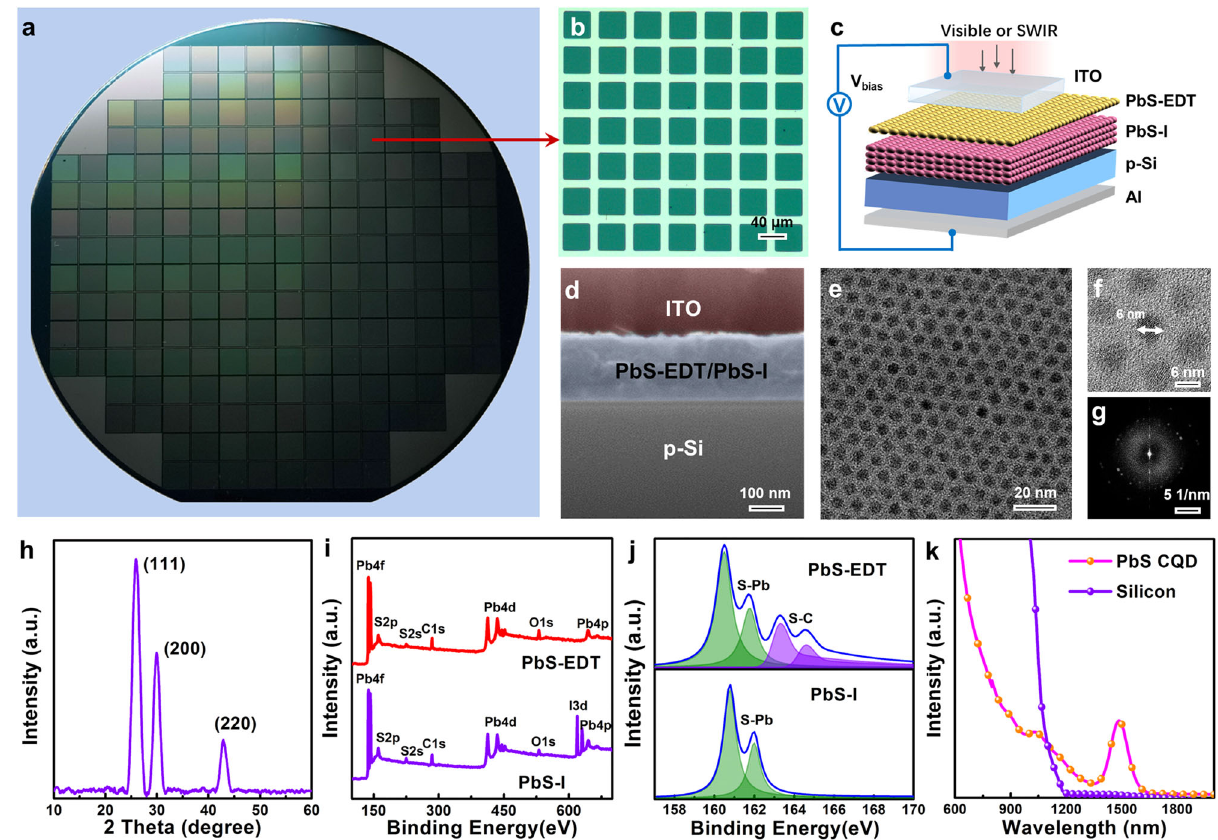
Fig. 1 Structure and material characterization of the PVTRI. a PVTRI arrays in a 4-inch silicon wafer. b The optical microscope image to show a minimum pixel (40 × 40 μ m) of the arrays. c The schematic device structure of a single Si:CQD PVTRI. At V bias < 0, the p-Si substrate acts as the emitter while the base and collector are consisted of the ultrathin PbS n-CQD and p-CQD fi lms, respectively. d The cross-sectional SEM image of the PVTRI. TEM ( e ) and HRTEM ( f ) images with the SAED patterns ( g ) of the PbS CQDs. h XRD analysis of PbS CQDs. XPS elementary composition ( i ) and S 2p peak spectra ( j ) of PbS-I and PbS-EDT. k Absorption spectra of the PbS CQDs and